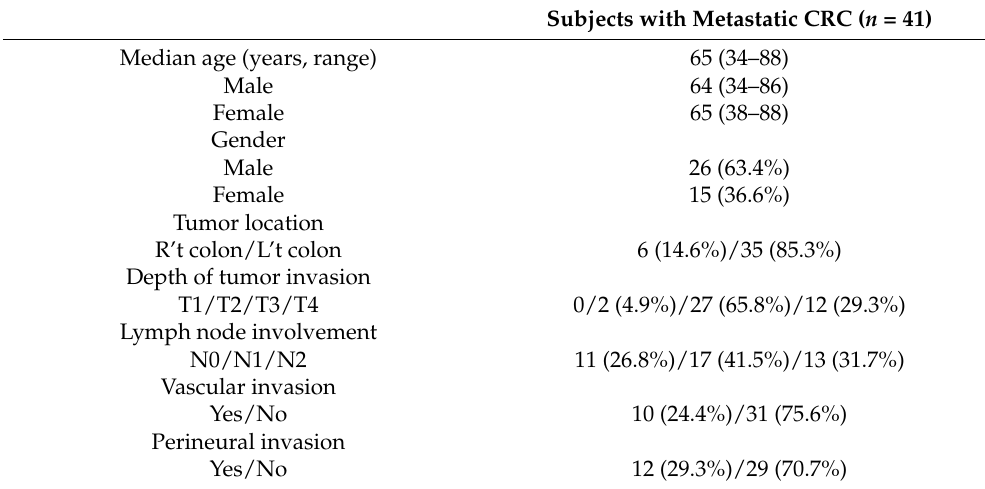
Table 1. Demographics of study patients ( n =